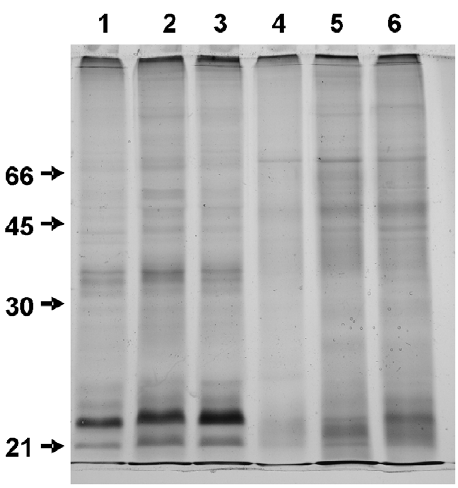
Figure 3. Denaturing polyacrylamide gel electrophoresis of invasive grastrovascular multicellular structures (IGMS) (lanes 1–3) for paired mesenterial filaments (Lanes 4–6) from coral fragments from three different infected colonies. Note protein bands at ca. 25 and 35 KD for IGMS not present in mesenterial filaments.